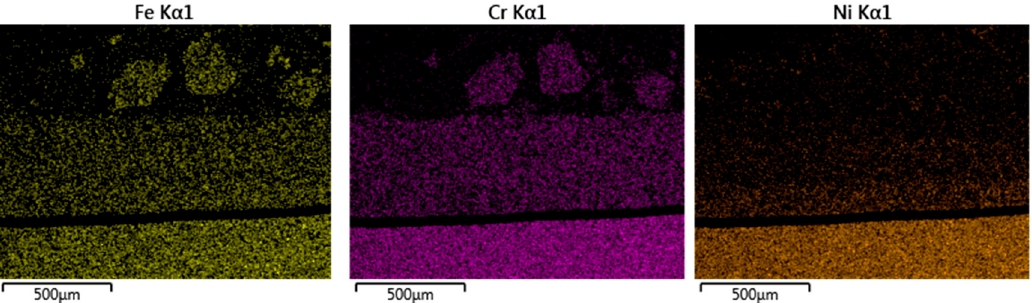
Figure 15. E Ni 6625/680 ± 20 °C/120 min/AlSi9. EDX semi-quantitative microanalyses (mapping).